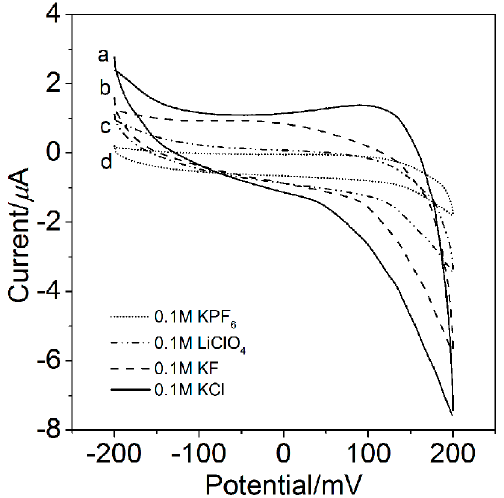
Figure 3. Cyclic voltammetry (CV) on the FS-SAM-modified gold electrode between − 200 and 200 mV in different electrolyte solutions: 0.1 M KCl (curve a ), 0.1 M KF (curve b ), 0.1 M LiClO 4 (curve c ), and KPF 6 (curve d ). Scan rate, 50 mV/s. pH: 7.0.